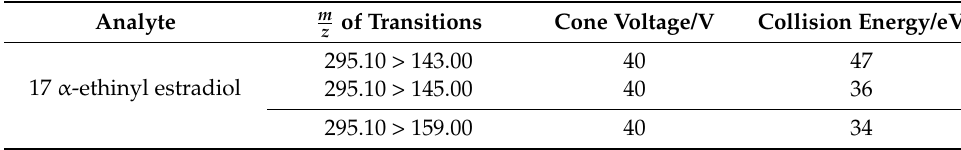
Table 3. Multireaction monitoring ion transitions utilized for qualification and quantification, m mass-to-charge ratio.